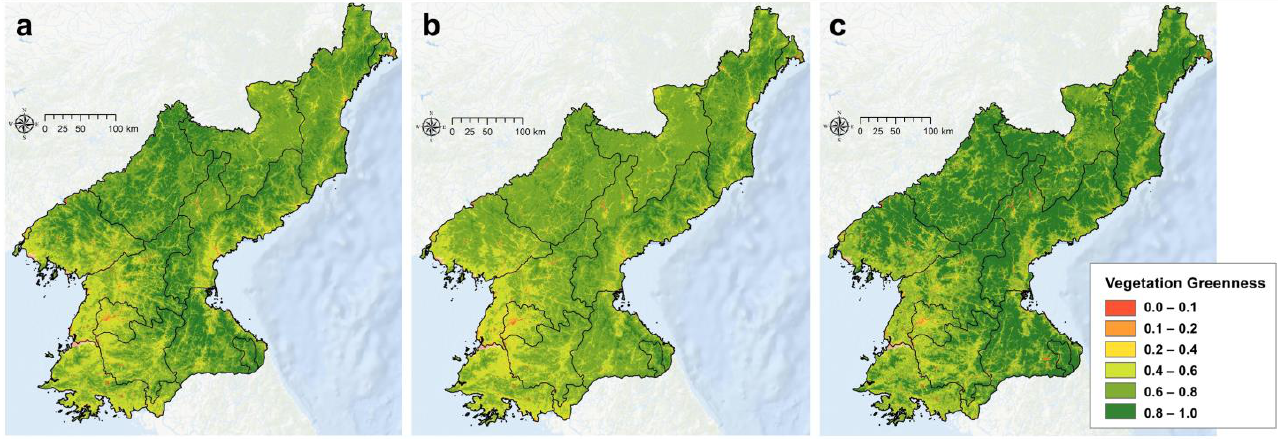
Figure 2. Spatial distribution of five-year average vegetation greenness: ( a ) 1986 – 1990, ( b ) 1991 – 1995, ( c ) 2017 – 2021.